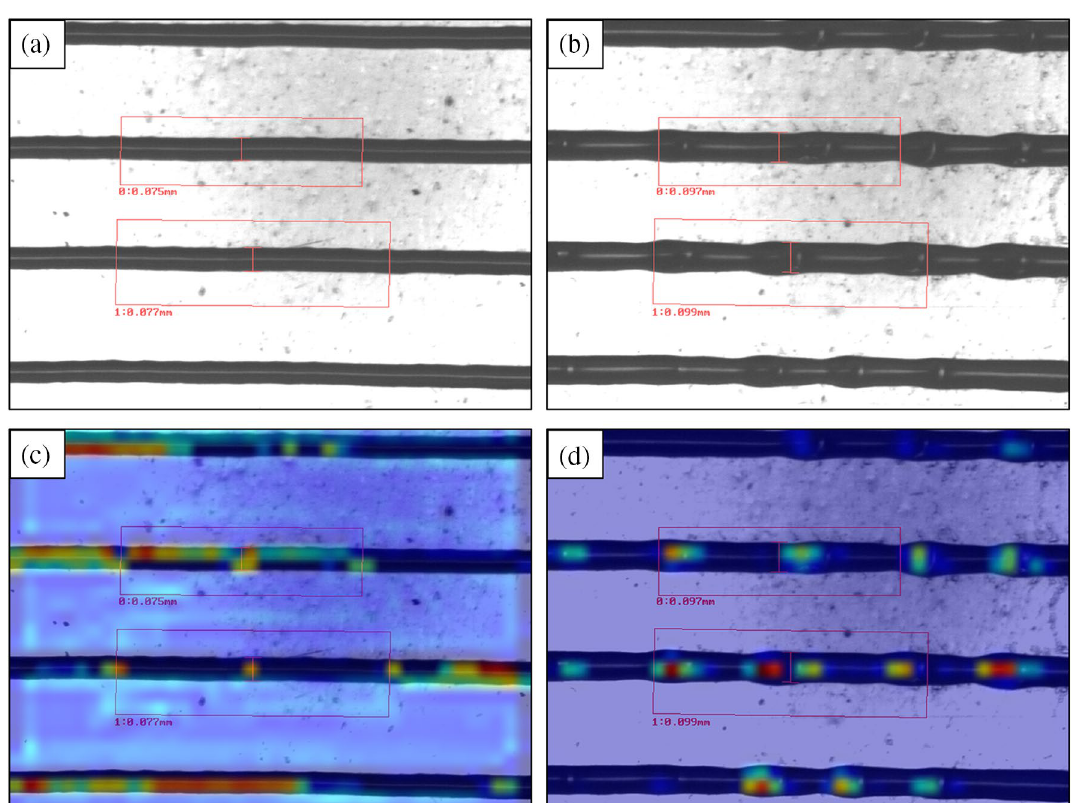
Figure 8. Grad-CAM images. The original images of printed lines ( a ) without and ( b ) with defects and superimposed with the Grad-CAM heat map’s original images for ( c ) printed lines without defects and (d) printed lines with